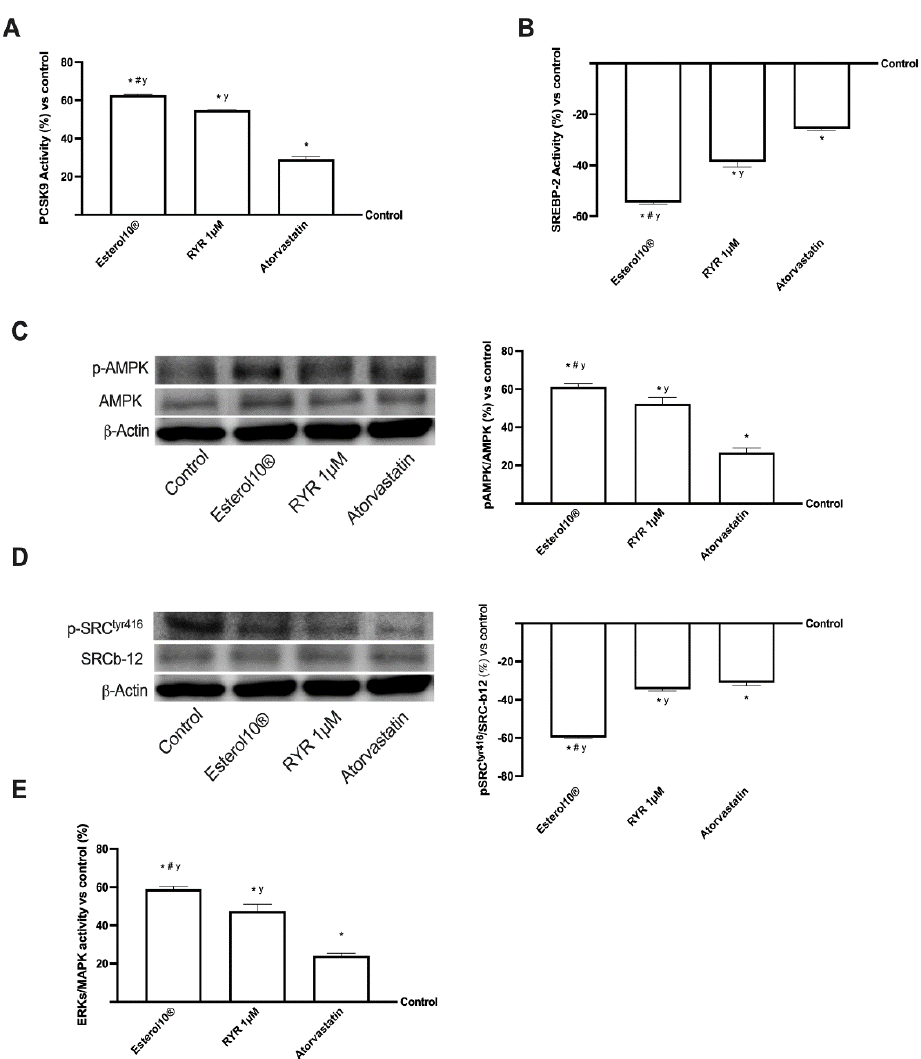
Figure 5. Intracellular pathways activated in HepG2 cells. In ( A , B , E ) the protein activity of PCSK9, SRC, and ERK was measured by an ELISA test; in ( C , D ) the analysis of AMPK and SRC performed by Western Blot and densitometric analysis. The abbreviations are the same reported in Figure 1. Data are mean ± SD of five independent experiments performed in triplicates. The images reported are an example of a Western blot obtained with technical replicates. * p < 0.05 vs. control; # p < 0.05 vs. RYR; y p < 0.05 vs.